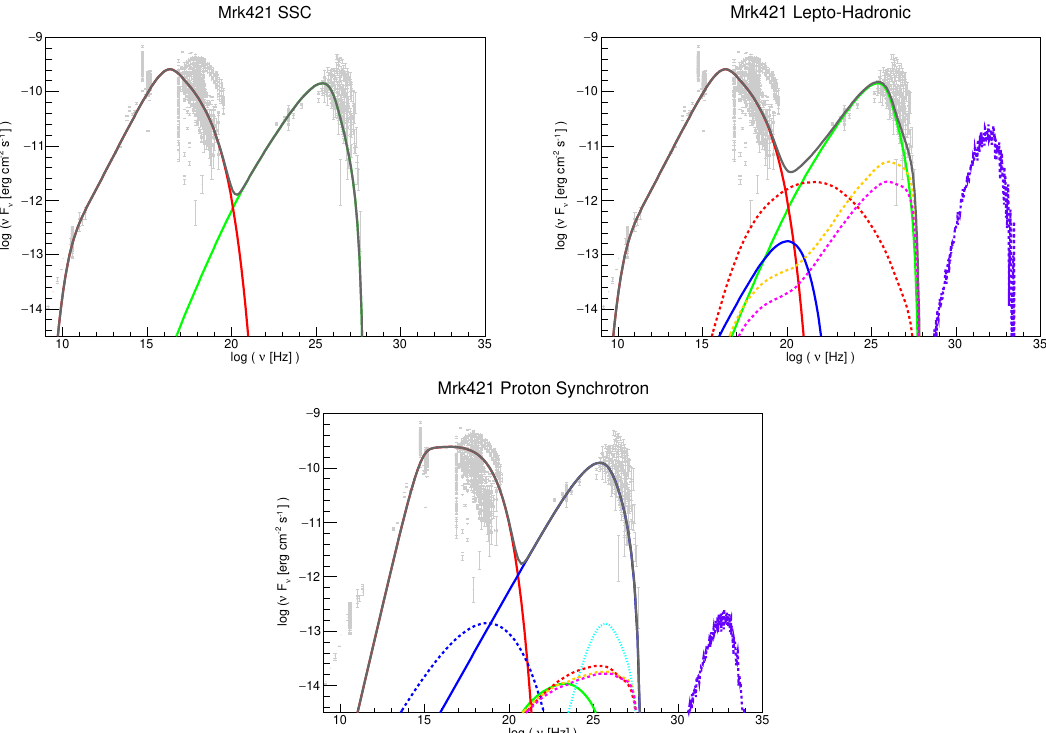
Figure 2. Spectral energy distribution of the high-frequency-peaked BL Lacertae object Markarian 421, showing in gray archival data from the SSDC SED builder (https://tools.ssdc.asi.it/SED/). Top left: one-zone SSC modeling of the SED, with in red synchrotron emission by electrons and in green synchrotron-self-Compton emission; model parameters are δ = 30, R = 1.6 × 10 16 cm, B (cid:48) = 40 mG, = 100, γ (cid:48) = 6 × 10 4 , γ (cid:48) = 10 6 , n = 1.8, n = 3.5, L e = 5.1 × 10 43 erg s − 1 . γ (cid:48) e ,2 e ,1 e , Max e , min e , break Top right: one-zone lepto-hadronic modeling of the SED, with in blue synchrotron emission by protons, in dotted-blue synchrotron emission by secondary pairs from proton–synchrotron, in dotted-red synchrotron emission by the Bethe–Heitler cascade, in dotted yellow synchrotron emission by the π 0 cascade, and in dotted pink synchrotron emission by the π ± cascade; neutrino emission is in violet; = 1, model parameters are same as the first plot, with in addition a proton distribution with γ (cid:48) p , min = 2 × 10 8 , n p = 1.8, L p = 1.3 × 10 47 erg s − 1 Bottom: one-zone hadronic modeling of the SED; γ (cid:48) p , Max = 300, γ (cid:48) = 3 × 10 4 , n e = 2.9, model parameters are δ = 30, R = 2.5 × 10 15 cm, B (cid:48) = 50 G, γ (cid:48) e , Max e , min = 1, γ (cid:48) = 3 × 10 9 , n p = 1.9, L p = 4.7 × 10 43 erg s − 1 L e = 5.4 × 10 39 erg s − 1 , γ (cid:48) p , Max p , min